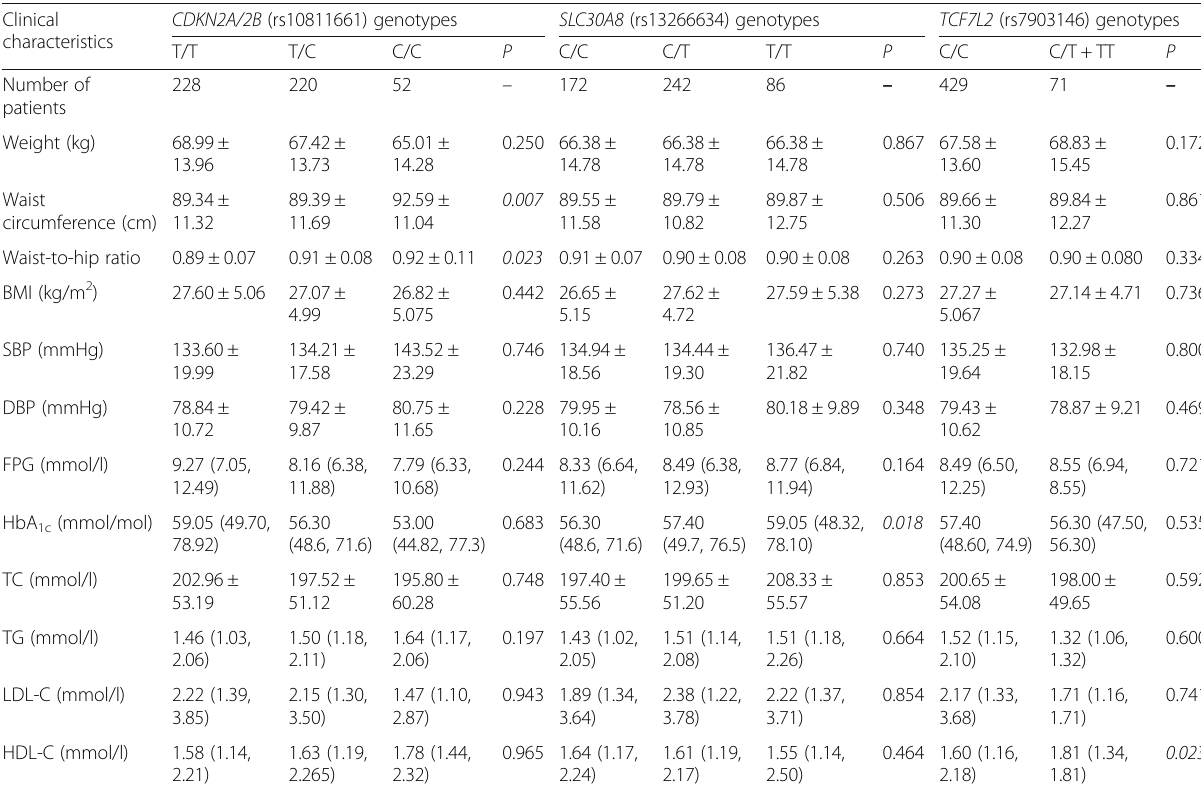
Table 3 Association between CDKN2A/2B (rs10811661) , SLC30A8 (rs13266634), and TCF7L2 (rs7903146) genotypes and quantitative traits among Thai patients with T2D Clinical